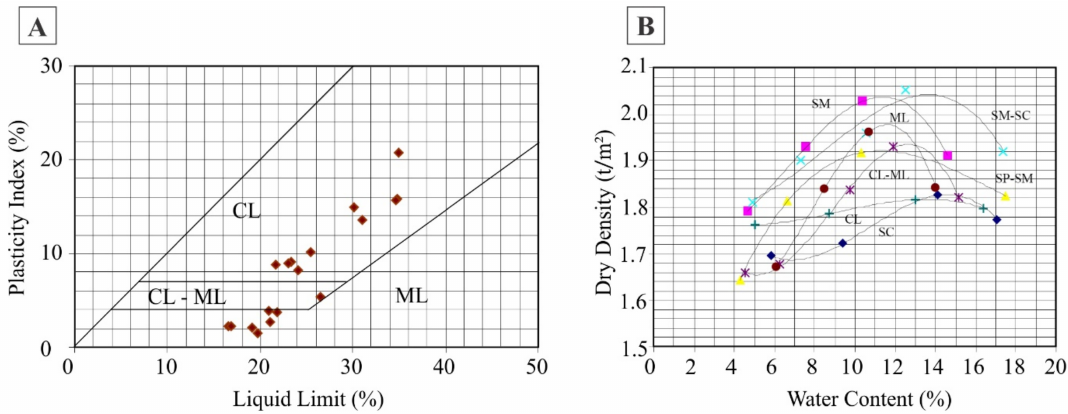
Figure 8. The plasticity chart ( A ) and standard proctor compaction curve ( B